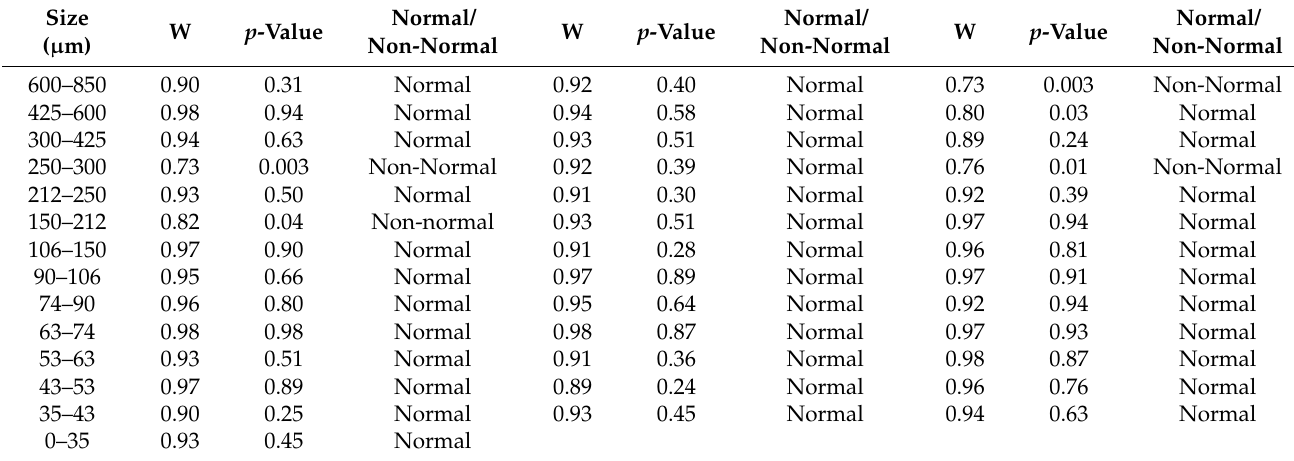
Table A9. Shapiro–Wilk test for the 8 min grinding test.